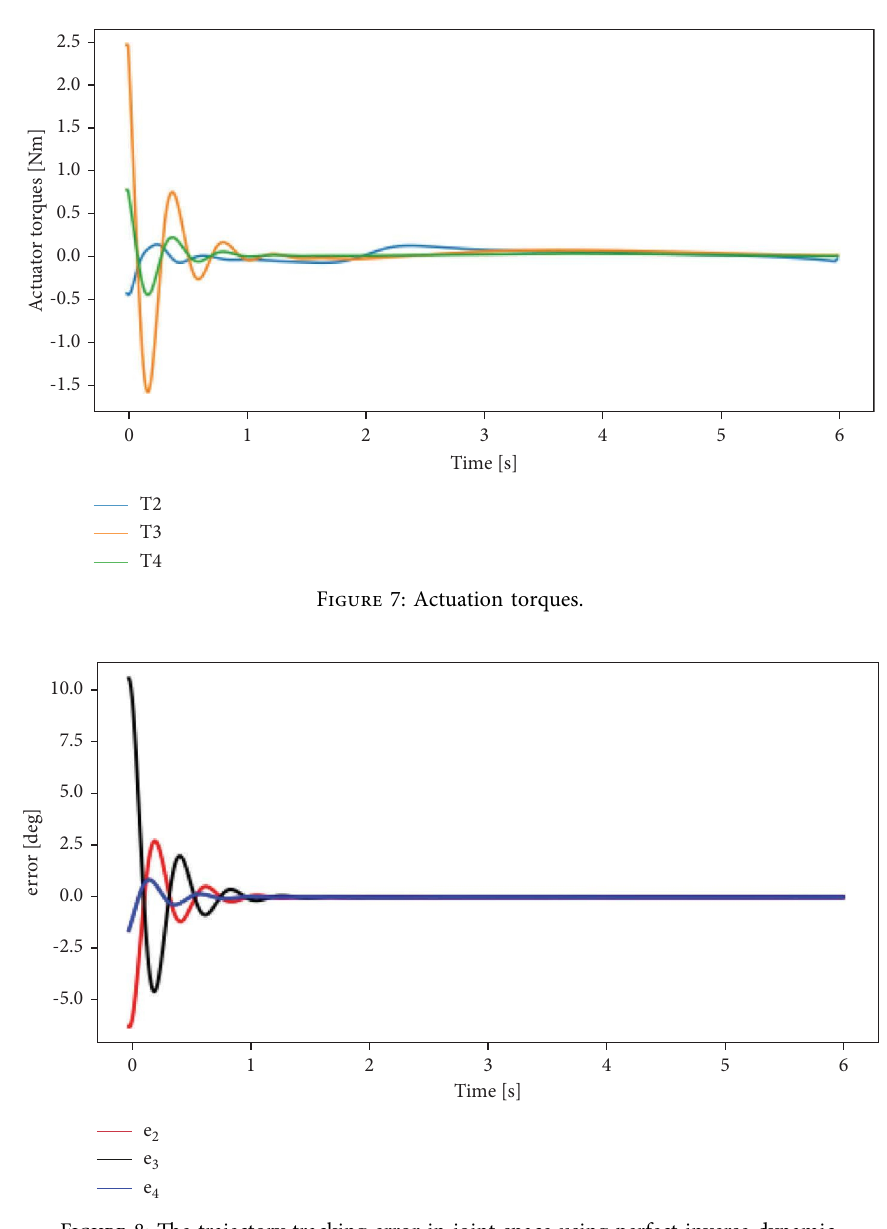
Figure 8: Te trajectory tracking error in joint space using perfect inverse dynamic.